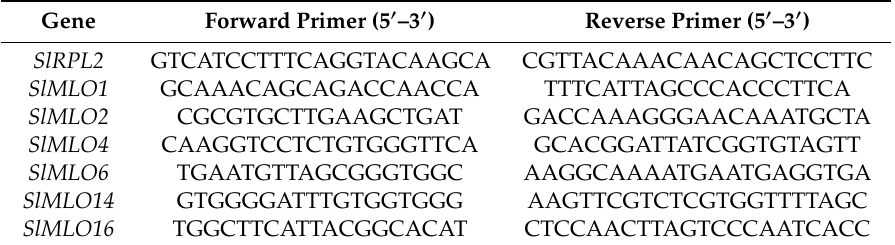
Table 2. Primers used for